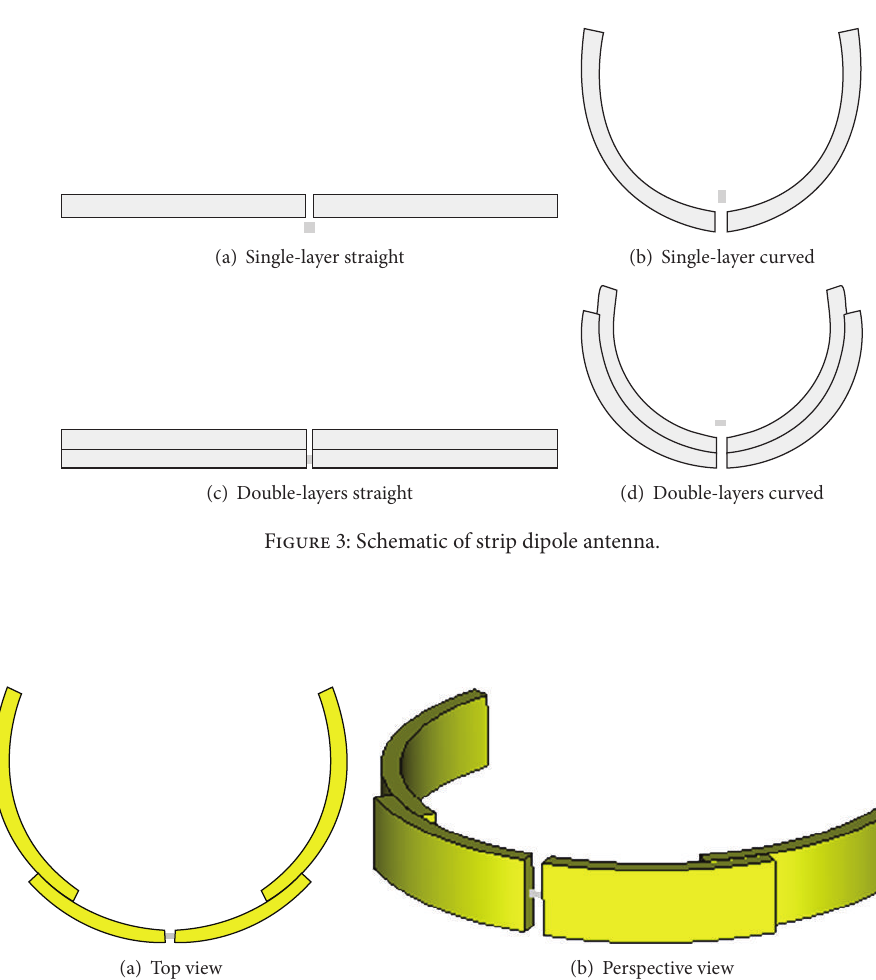
Figure 4: Double-layers strip dipole antenna